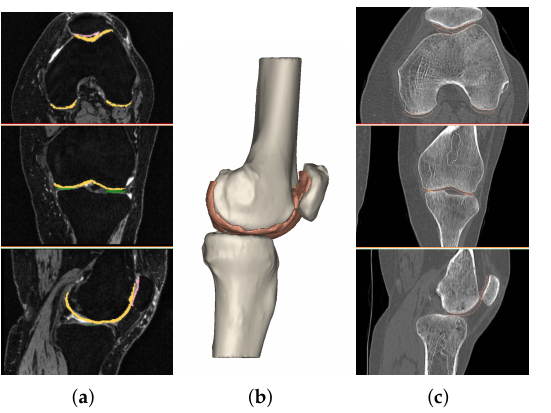
Figure 1. ( a ) Segmentation of femur cartilage from MRI file. ( b ) A 3D model of bones and cartilages. ( c ) Registration on CT file.